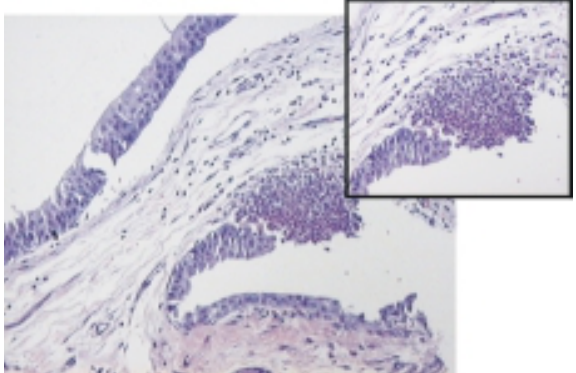
FIGURA 4 - Cistite ativa; urotélio estratificado, múltiplos focos de exocitose com poli e monomorfonucleares (detalhe). Lâmina própria edemaciada com vasos congestos. (HE x100 ; HE x